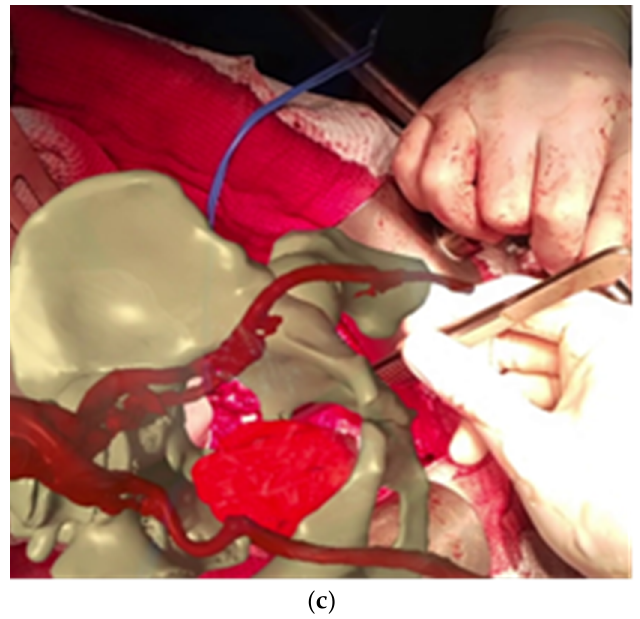
Figure 7. ( a ) Surgeon at work with augmented reality glasses; ( b , c ) Visualization of the 3D anatomy model and physician interface in the augmented reality glasses.